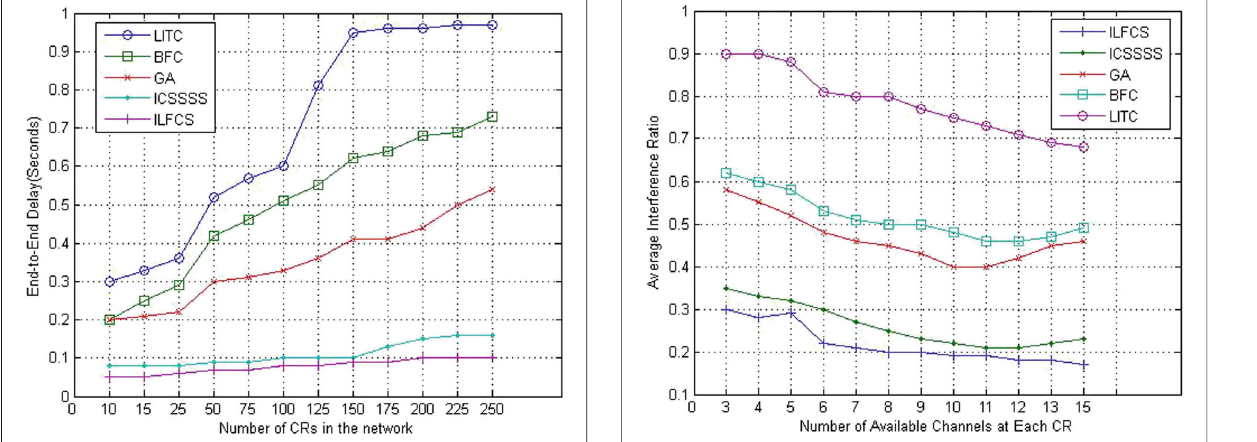
Fig. 11 End-to end delay under different network density. The results of diverse simulation experiments to measure the End-to end delay at different numbers of CR nodes for the BFC, LITC, GA, ICSSSS and the ILFCS are illustrated